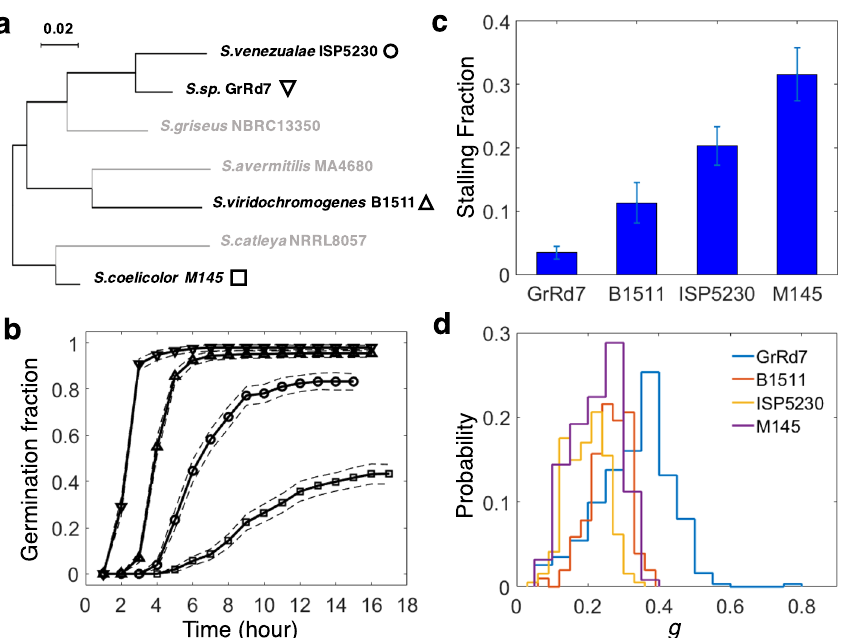
Figure 2. Germination and growth of spores of four Streptomyces species. ( a ) Phylogenetic relationship of the 4 investigated Streptomyces species. ( b ) The germination curves of the 4 species. The curves differ in the onset of germination, germination rate, and final fraction of germinated spores. Dashed curves show 95% confidence intervals. ( c ) Shown is the fraction of germlings that stopped growing soon after germination for the dataset in ( b ). Error bars indicate 95% confidence intervals. ( d ) Shown are the distributions of mycelium growth rates for the four strains. All the data was taken with the same media, spore concentration, and spore age. See additional figure data in